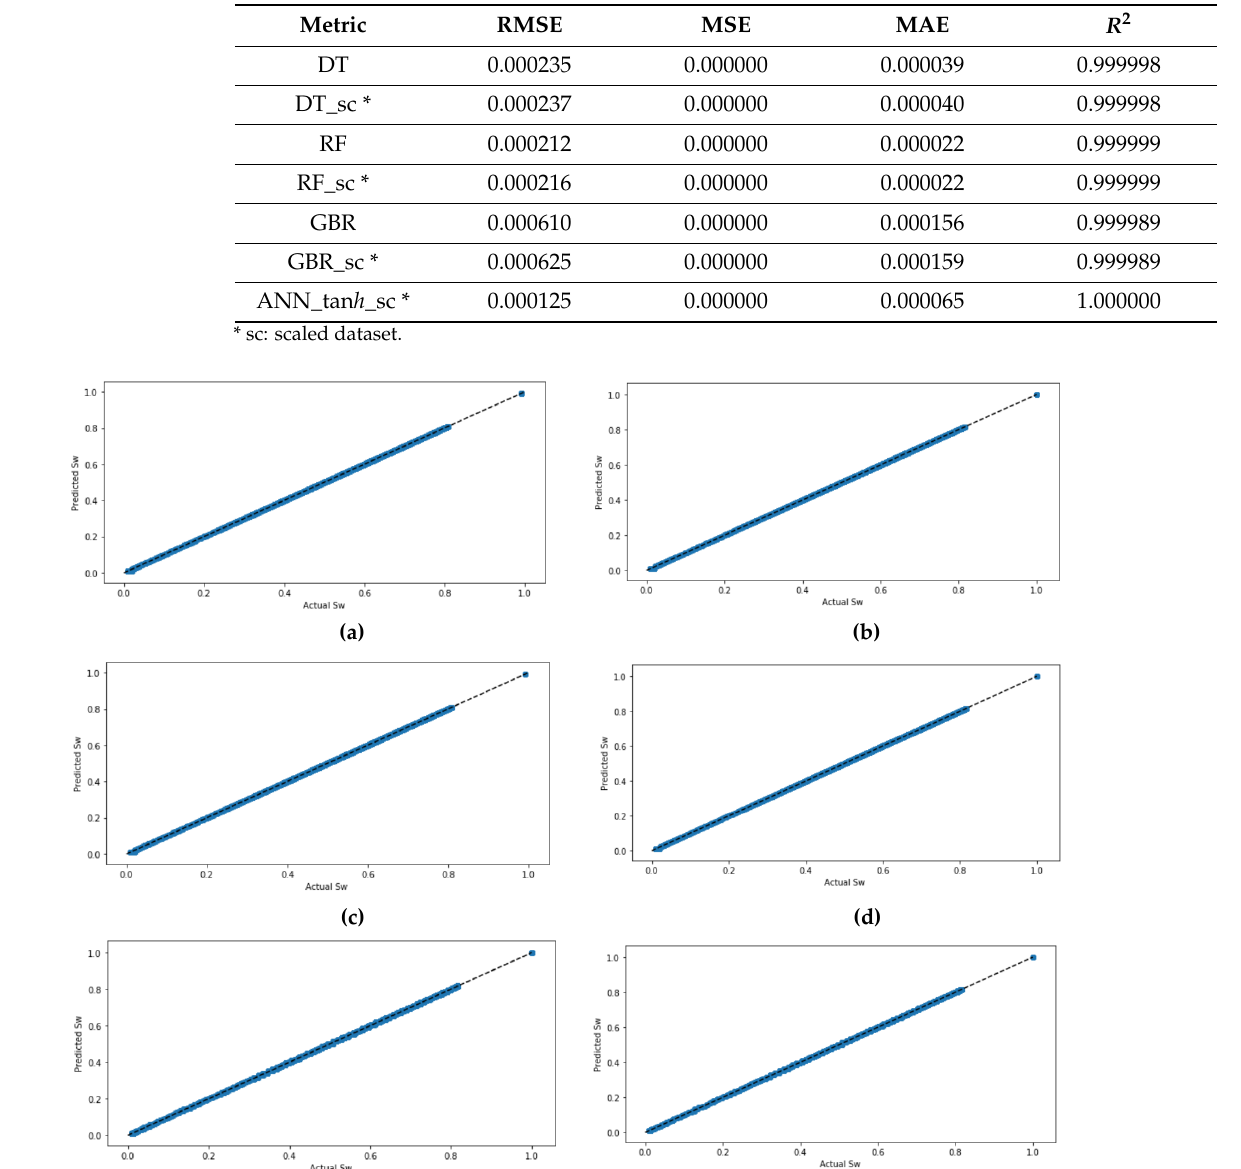
Table 5. Models performance evaluation of two phases dataset for S w .